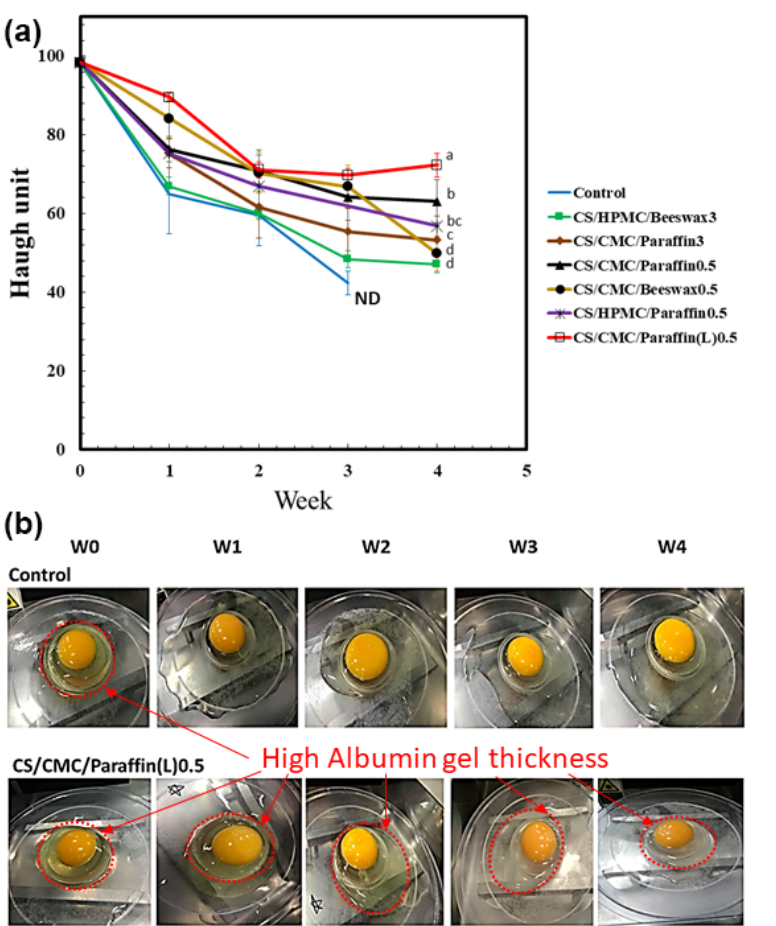
Figure 2. Quality of the coated and uncoated eggs: ( a ) Variation in Haugh units (HUs) ( n = 5) of cassava starch (CS) blended with hydroxypropyl methylcellulose (HPMC), carboxymethyl cellulose (CMC), beeswax, paraffin, and low-molecular-weight paraffin wax (Paraffin(L)) during storage from day 0 to week 4 at 25 ± 3 °C and 65 ± 2% relative humidity. The control indicates uncoated eggs. ND indicates not detected. Means with different lowercase superscript letters were significantly different ( p < 0.05). ( b ) Images of uncoated eggs (control) and eggs coated with CS/CMC/Paraffin(L)0.5 from day 0 to week